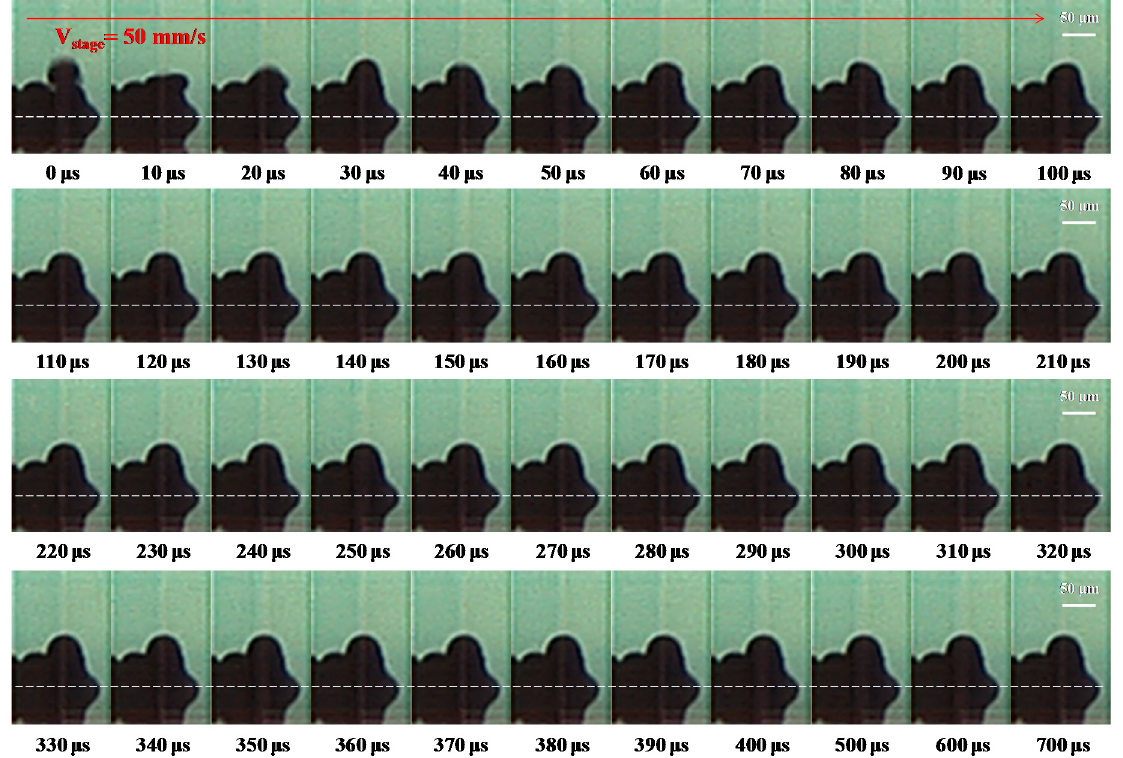
Figure 11. Evolution of the incoming droplet under a dot spacing of 50 μ m impacting onto a solidified droplet recorded using a high-speed digital camera with condition F in Table 2. The dashed lines separate the outline of the droplet from that of its reflection onto a substrate at 70 °C (Ste = 0.567). The scale bars are 50 μ m.